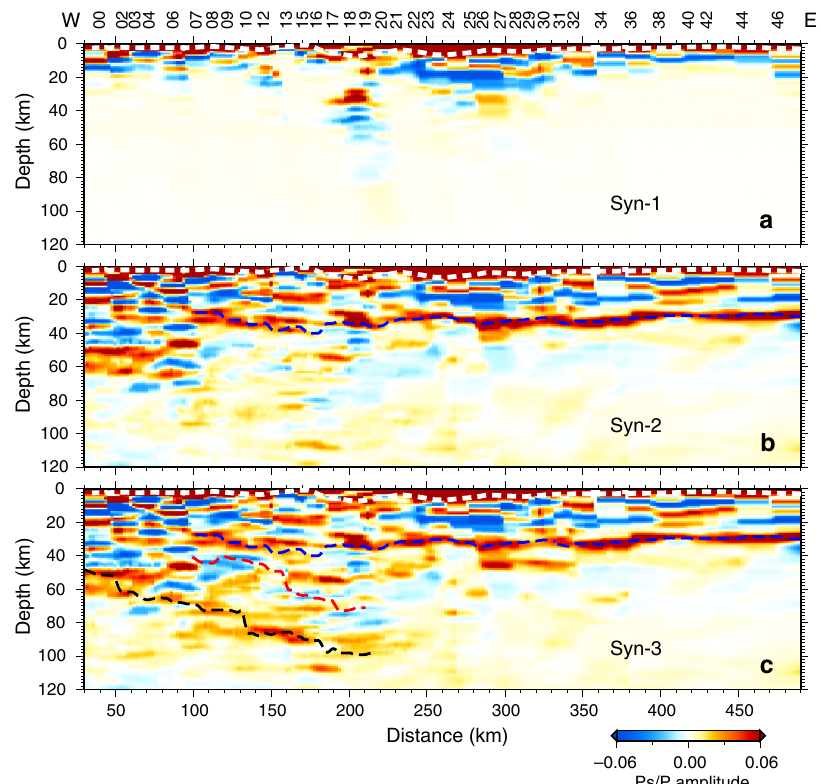
Fig. 3 Synthetic test of the common conversion point (CCP) imaging. a Syn-1 is calculated based on the model with a homogeneous medium underlying the sedimentary cover resulting from the waveform inversion. b Syn-2 is calculated based on the model with a homogeneous mantle medium underlying the crustal models above ~35 km resulting from the waveform inversion. c Syn-3 is the synthetic CCP image calculated based on the model with a dipping structure in the upper mantle. To show the structural features of the imaged crust and mantle wedge more clearly, a lighter color bar is used in the unstudied part of the mantle. Dashed lines in the CCP image mark the locations of velocity discontinuities, including the basement (white), Moho (blue), top interface (red) and bottom interface (black) of the dipping structure from the observed CCP image (Fig. 4A). The strong positive phase at a depth of ~30 km in the observed well-constructed crustal structure, no dipping structure with two CCP image is the converted phase from the Moho. To distinguish parallel phases (negative phase above and positive phase below) the multiples from intracrustal interfaces and real interfaces in appears in the upper mantle beneath stations M00 – M19, which is the upper mantle, we iteratively run the above process. The Syn-2 different from the observed CCP image. This result indicates that image (Fig. 3B) is calculated based on the synthetic receiver the two parallel phases represent velocity discontinuities in the functions generated by the velocity models of a homogeneous upper mantle, rather than multiples generated by intracrustal mantle medium underlying the crustal models resulting from interfaces. Syn-3 (Fig. 3C) is the synthetic CCP image obtained the waveform inversion. As shown in Fig. 3B, despite the from the model with a dipping structure in the upper mantle.